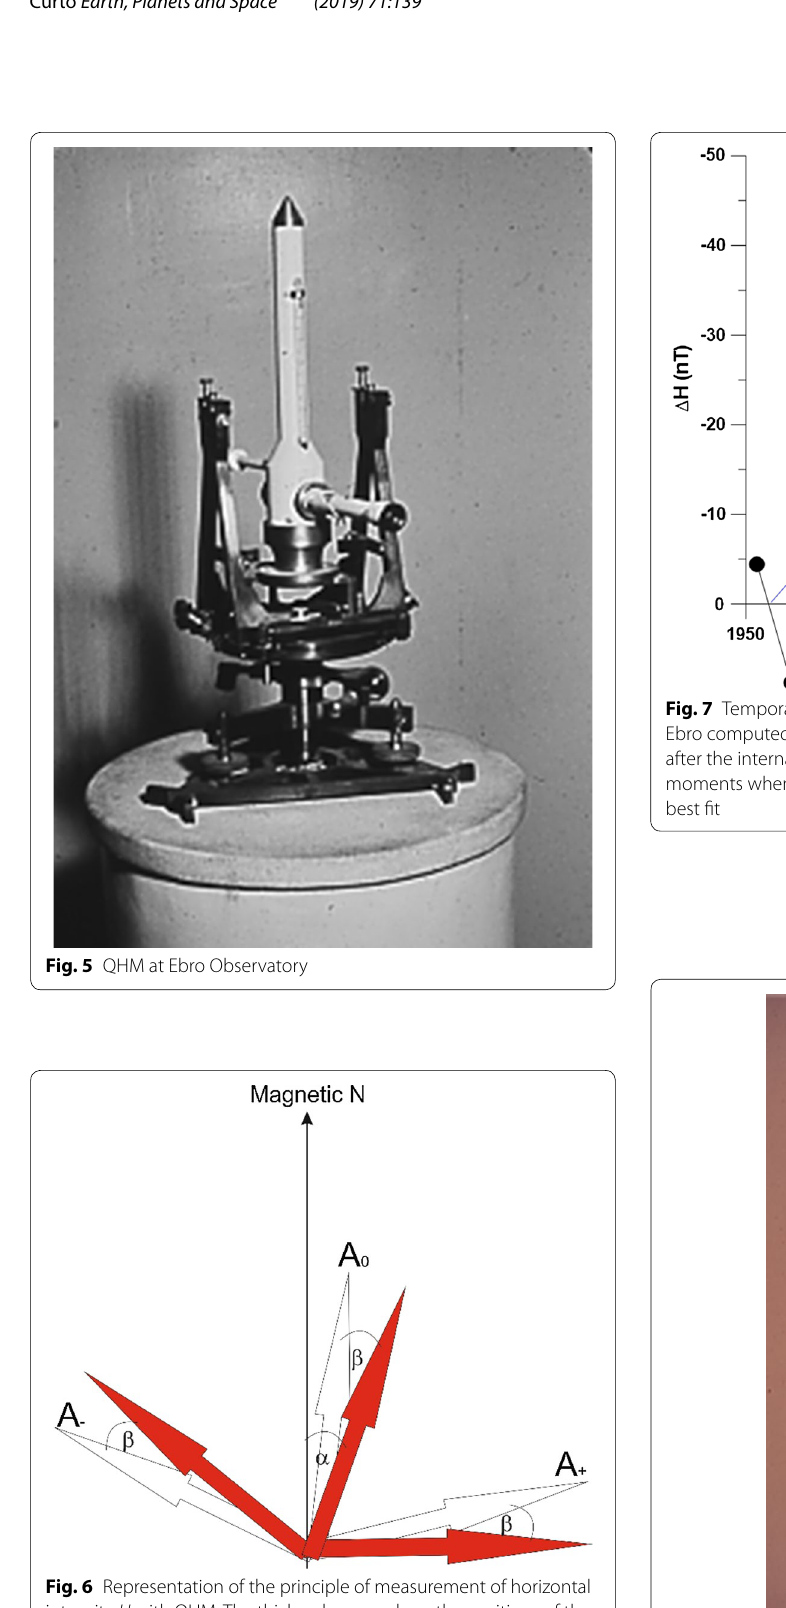
Fig. 6 Representation of the principle of measurement of horizontal intensity H with QHM. The thick red arrows show the positions of the magnet. The angles β between the directions of the magnet and the theodolite directions, A readings, were caused by collimation. The small angle, , was caused by the torsion of the suspending fiber